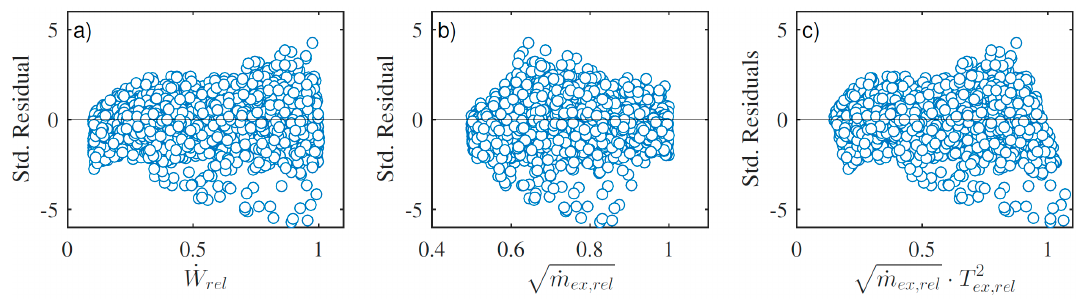
Figure 9. Off-design regression model, standard residuals distribution according to the target data and regression parameters.